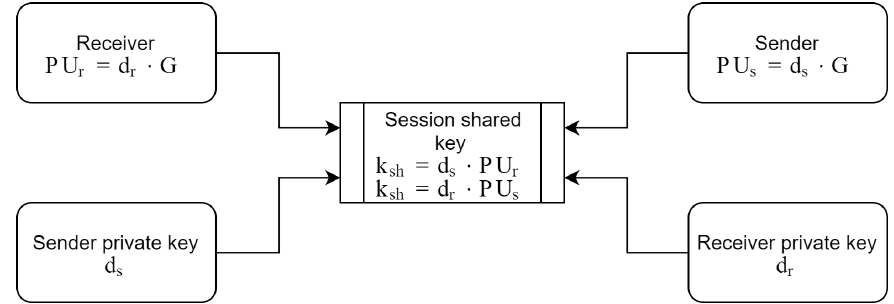
Figure 2. Generate the shared key between two